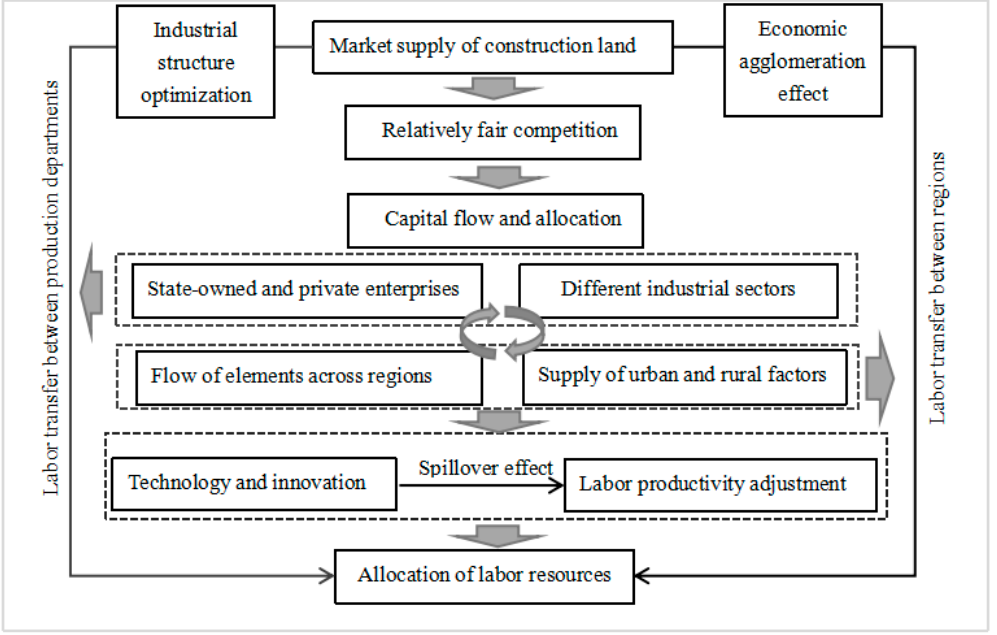
Figure 1. Relationship between MSCL and LMIS.